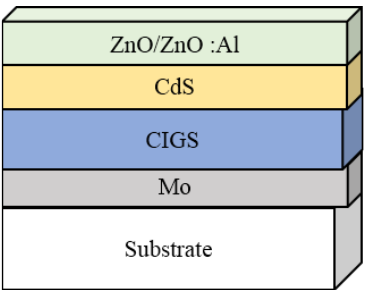
Figure 11: The configuration of the CIGS sub-cell